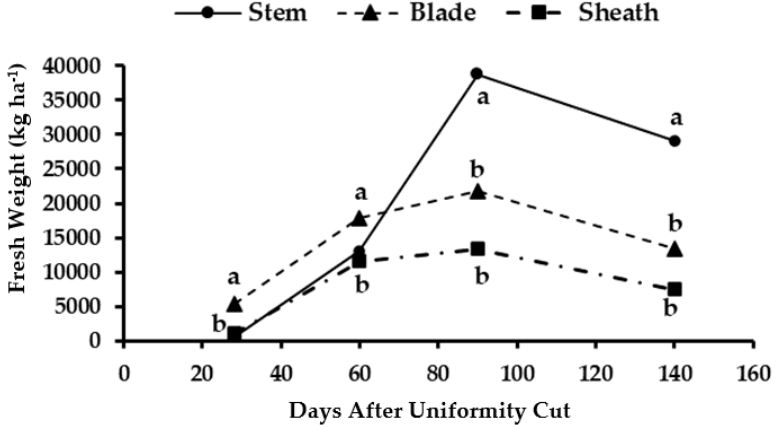
Figure 2. Fresh biomass accumulation in different organs of the apical stratum of maralfalfa plants harvested at different cutting dates. The weight values with equal letters in each stratum of the plant were statistically similar ( p ≤ 0.05).